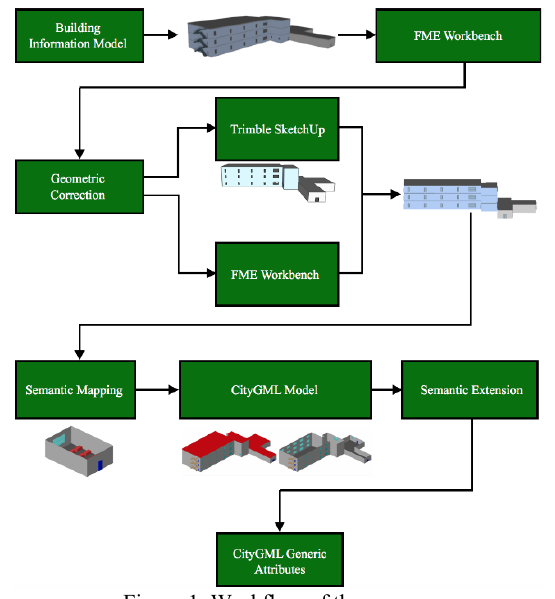
Figure 1: Workflow of the